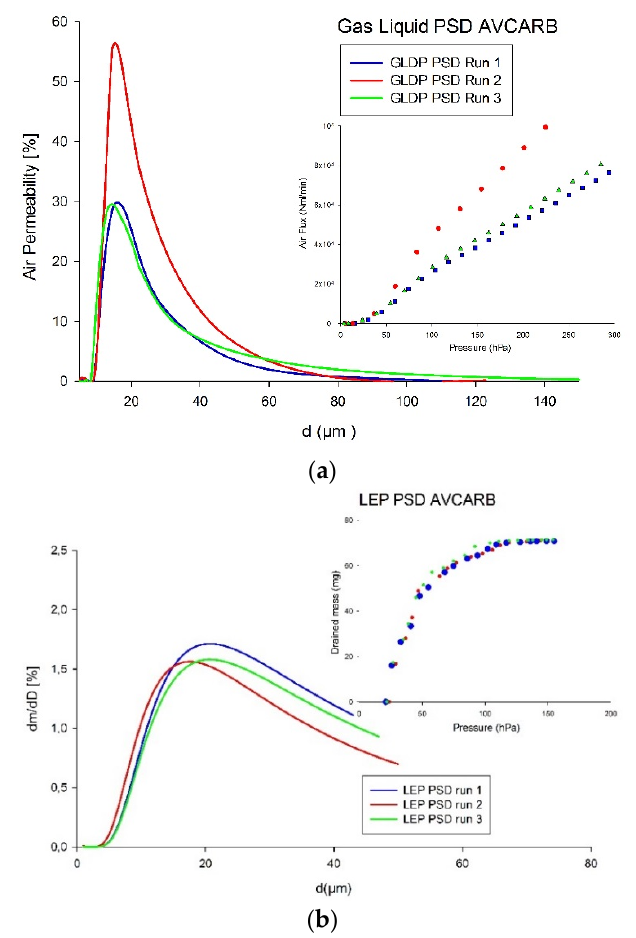
Figure 3. Experimental curves and resulting PSDs of AVCARB GDL by ( a ) GLDP; ( b )